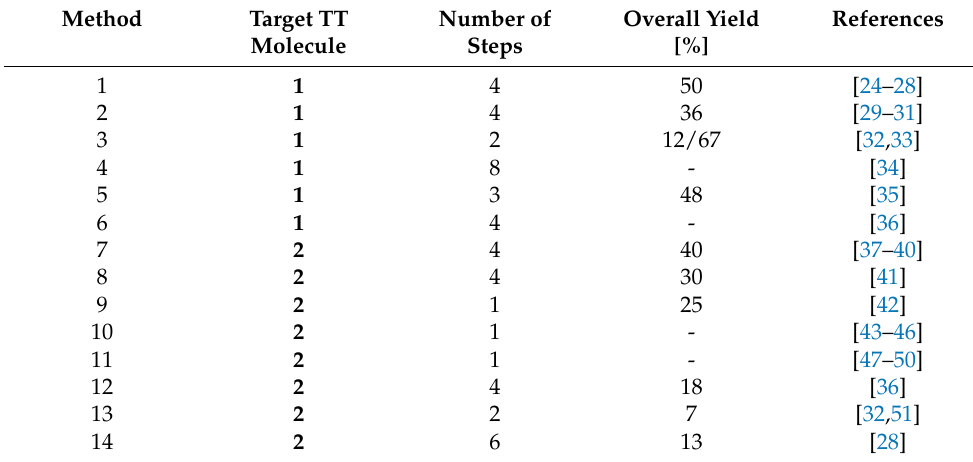
Table 1. The summary of the reviewed synthetic